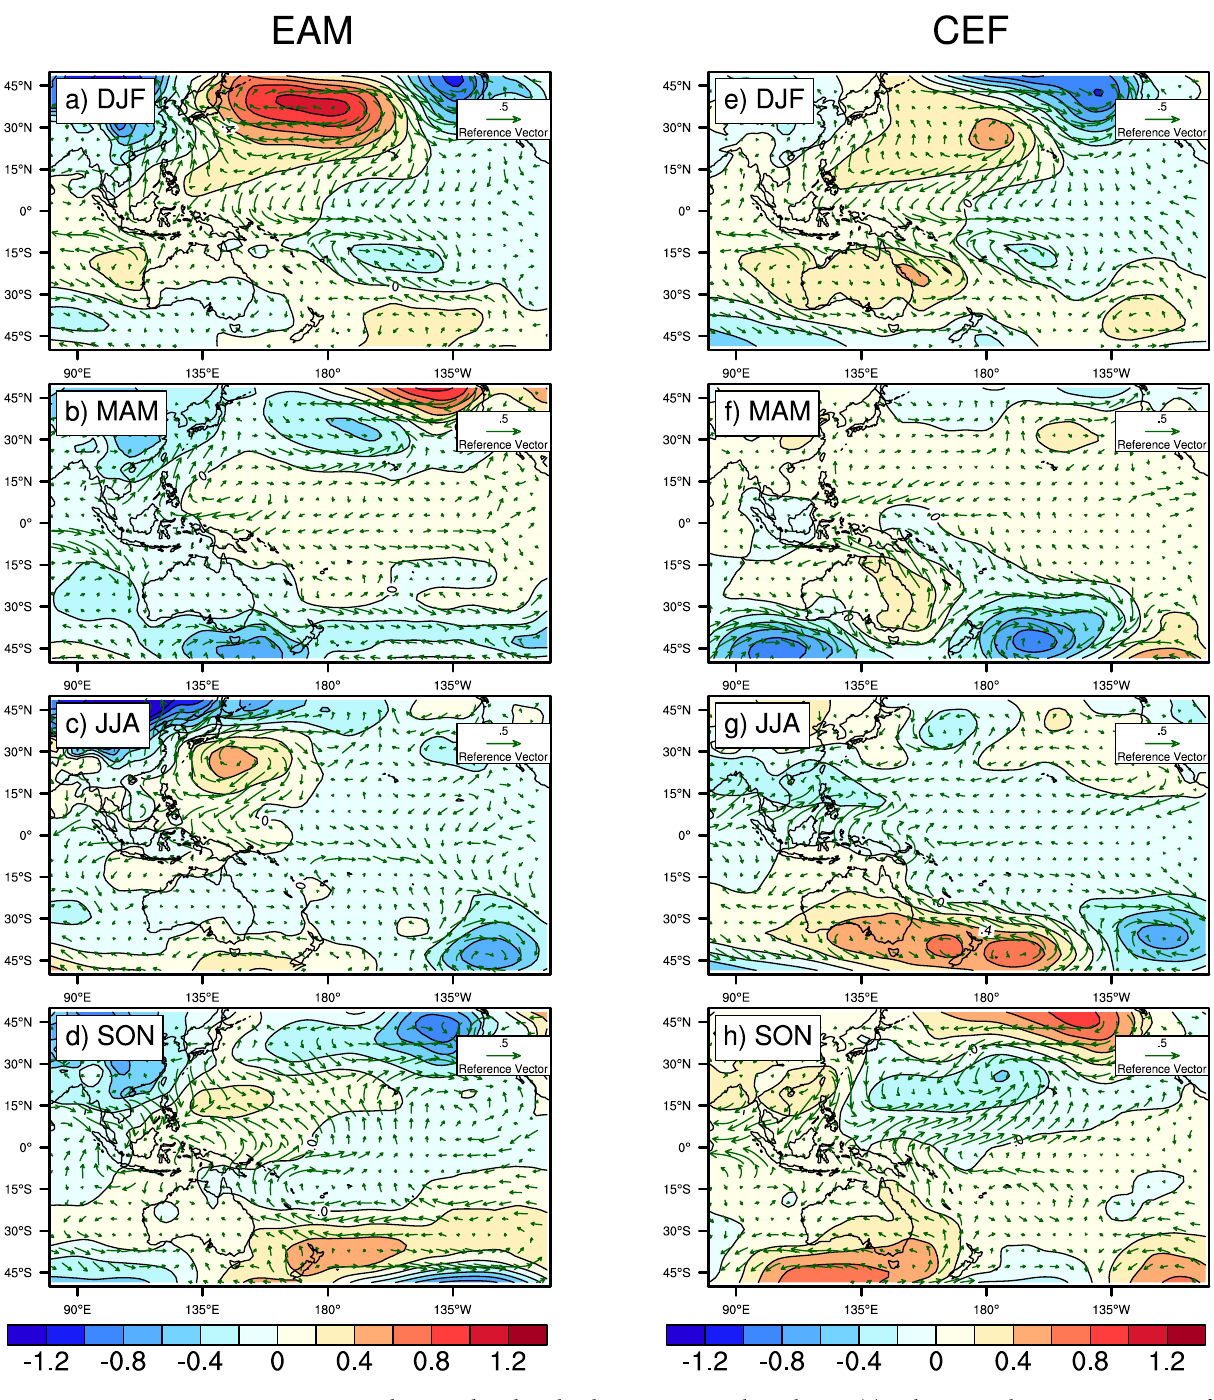
Figure 4. EAS- and CEF-induced sea level pressure anomaly evolution. ( a) is the seasonal regression patterns of the bandpass-filtered mean sea level pressure anomalies and the winds (as shown in vectors) onto the monthly East Asia monsoon (EAM) index in DJF. ( b–d) are the same as ( a) but in MAM, JJA, and SON, respectively. ( e–h) are the same as ( a–d) but with cross-equatorial flow (Australian monsoon region). Maps were generated using the NCAR Command Language (NCL; https ://www.ncl.ucar.edu/), version 6.6.2 57 linked to westerly wind anomalies (the CEF associated with the SLPa evolution patterns shown in Fig. 4g). The extratropical high-pressure system located on the Australian STR in JJA initiates a strong southeasterly wind anomaly in SON. The correlation coefficient between the CEF and STR-I in JJA is 0.64 and in SON is 0.65, while the correlation coefficient between the CEF and the IMFs 6–8 in SON is 0.46. The impacts of the CEF remain until DJF (details in Table S1 and Fig. 4e-h). Meanwhile, no correlation was found between the CEF and IMFs 6–8 in the MAM season.